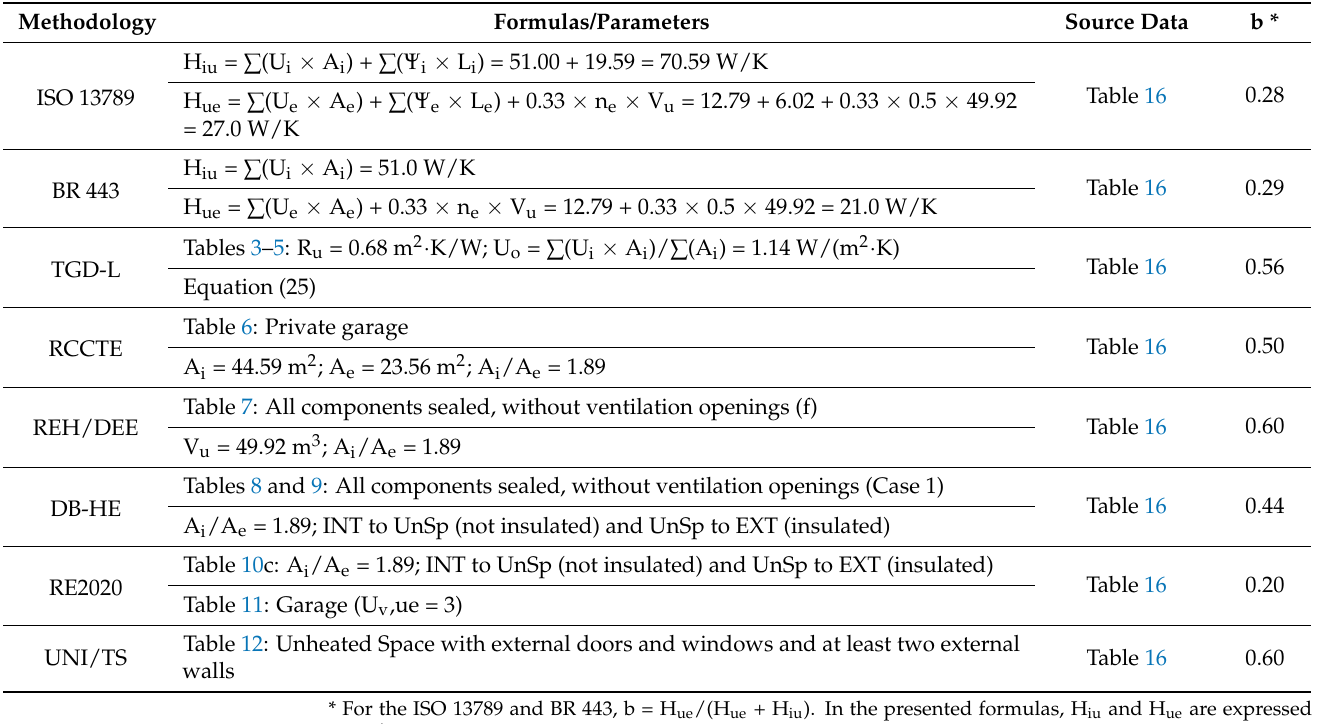
Table 10c: A i /A e = 1.89; INT to UnSp (not insulated) and UnSp to EXT (insulated) Table 11: Garage (U v ,ue = 3) Table 12: Unheated Space with external doors and windows and at least two external UNI/TS walls